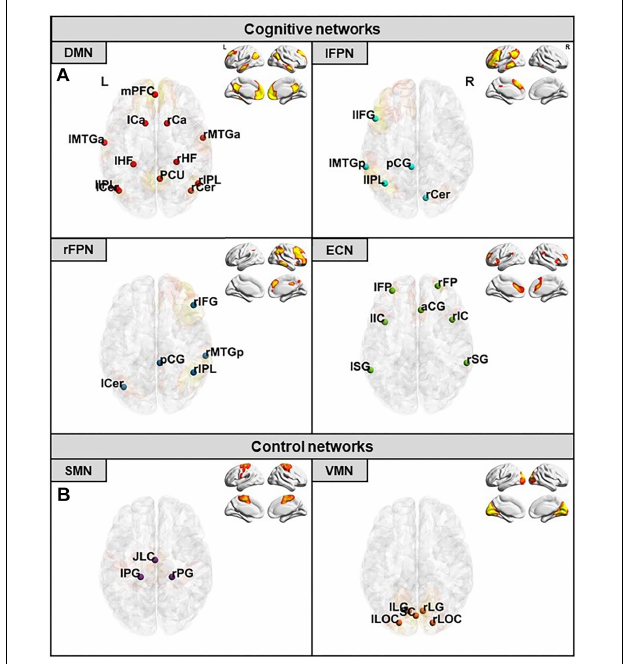
FIGURE 2 | Selected networks and their respective ROIs location. (A) Cognitive networks with their corresponding ROIs in red for the DMN, in light blue for the lFPN, in dark blue for the rFPN, and in green for the ECN. (B) Control networks with their corresponding ROIs in purple for the SMN and in orange for the VMN. DMN, default-mode network; lFPN, left fronto-parietal network; rFPN, right fronto-parietal network; ECN, executive-control network; SMN, sensorimotor network; VMN, visual-medial network. For ROI abbreviations see Table 1